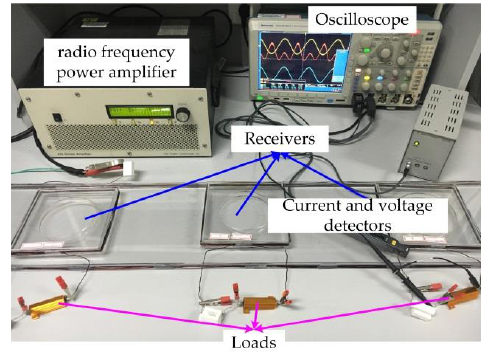
Figure 8. Configuration of the designed scaled-down experimental prototype.